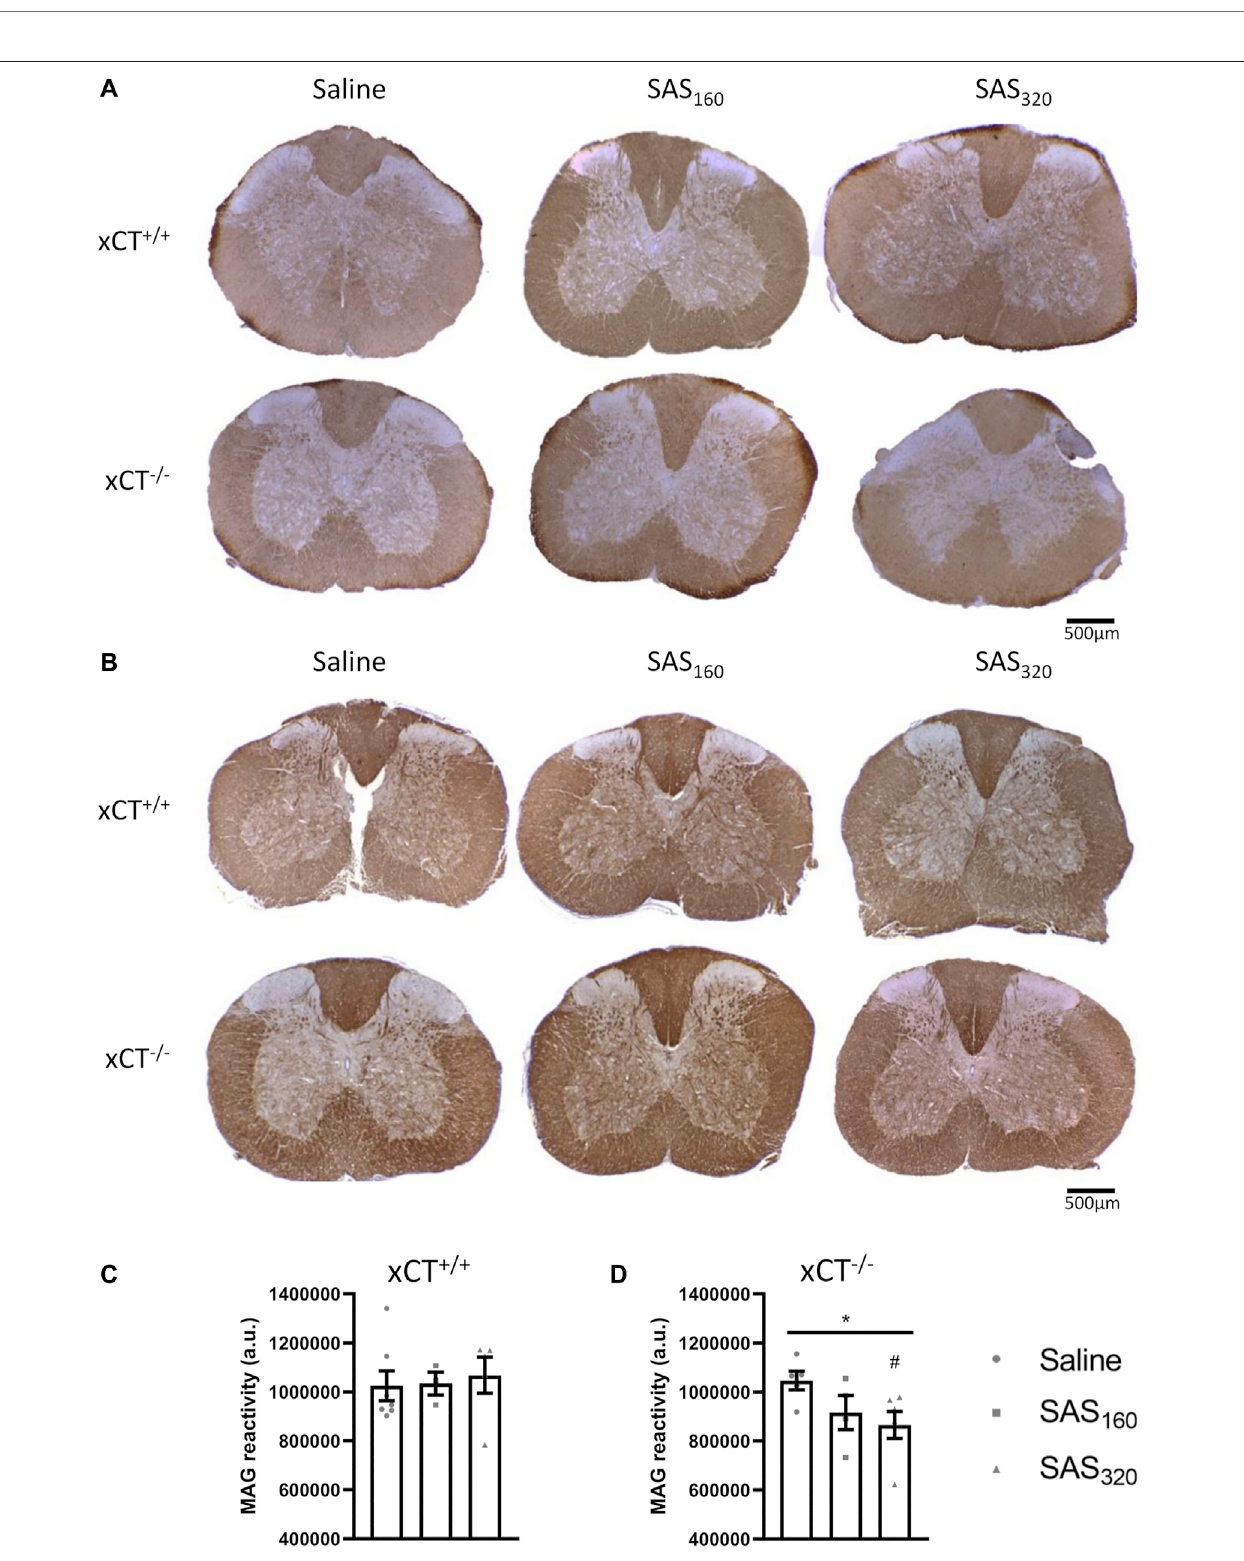
FIGURE 8 | Effects of chronic sulfasalazine (SAS) treatment on myelin in the spinal cord. Representative photomicrographs of myelin basic protein (MBP) (A) and myelin-associated glycoprotein (MAG) immunostaining (B) as well as quanti fi cation of the MAG staining (C,D) . One slice of n (cid:2) 3 – 7 mice/group was used, data are presented as mean ± SEM and analyzed using a Kruskal-Wallis test (* p < 0.05) followed by Dunn ’ s multiple comparisons for each dose of SAS compared to saline ( # p < 0.05).